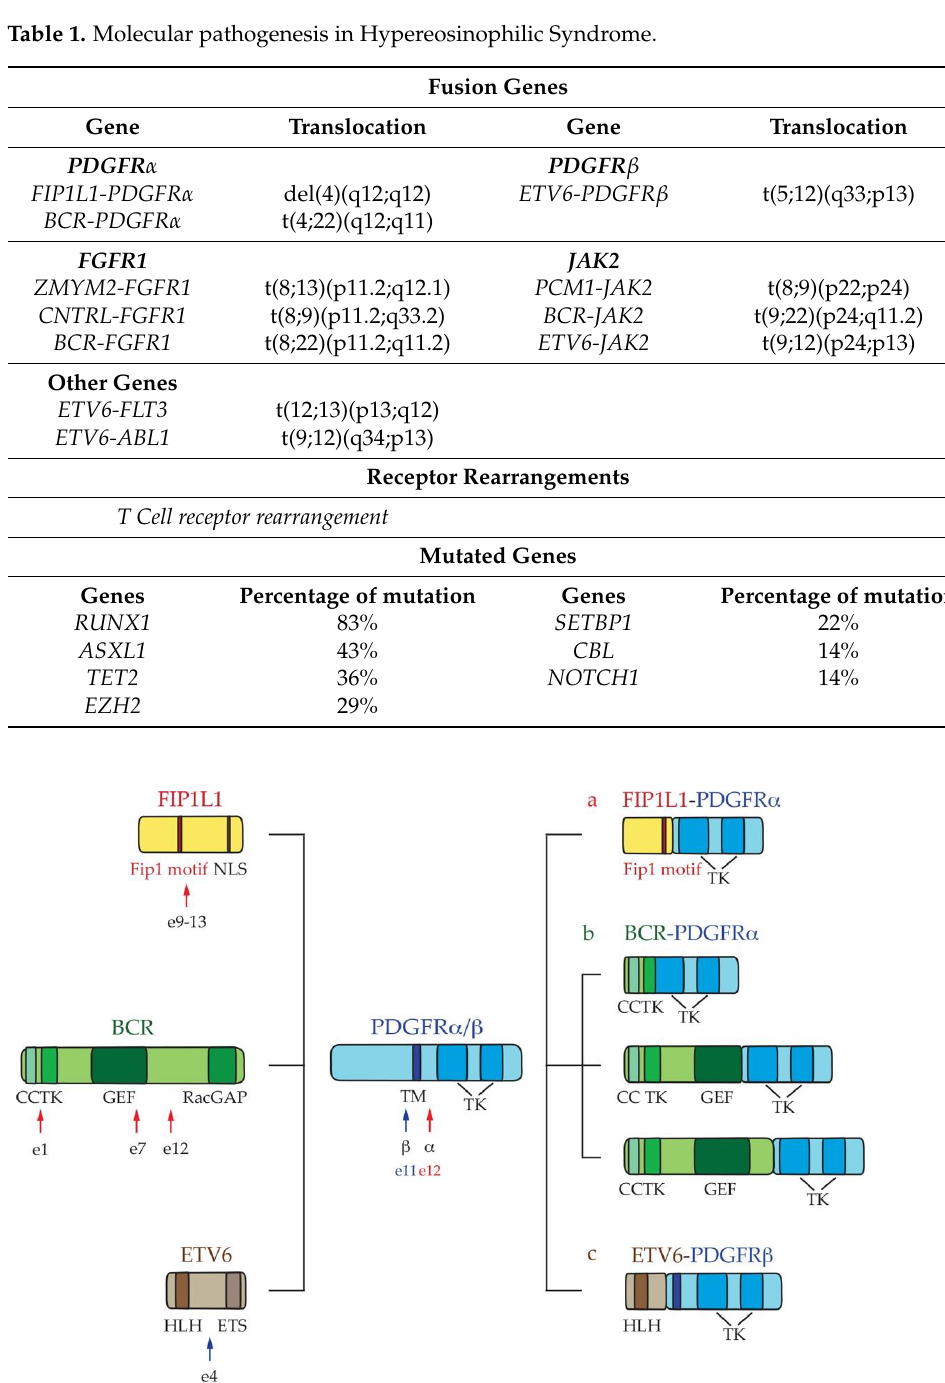
Figure 2. Schematic representation of platelet-derived growth factor receptor alpha ( PDGFR α ) and PDGFR β fusion rearrangements. (a) FIP1L1-PDGFR α ; (b) breakpoint cluster region- PDGFR α ( BCR-PDGFR α ); and, (c) ETV6 - PDGFR β . The arrows indicate the position of breakpoints of PDGFRs. BCR = breakpoint cluster region; CC = Coiled-Coil; ETS = (Erythroblast Transformation Specific) DNA-binding domain; ETV = ETS Variant Transcription Factor 1; FIP1L1 = Fip1-like1; GEF = Guanine Nucleotide Exchange Factor; HLH = Helix-Loop-Helix oligomerization domain; NLS = Nuclear Localization Signal; PDGFR = Platelet-Derived Growth Factor Receptor; RacGAP = COOH-terminal GTPase Activating Protein (GAP) domain; TM = Transmembrane; TK = Tyrosine Kinase. FIP1L1-PDGFR α fusions: the FIP1L1-PDGFR α rearrangement represents the